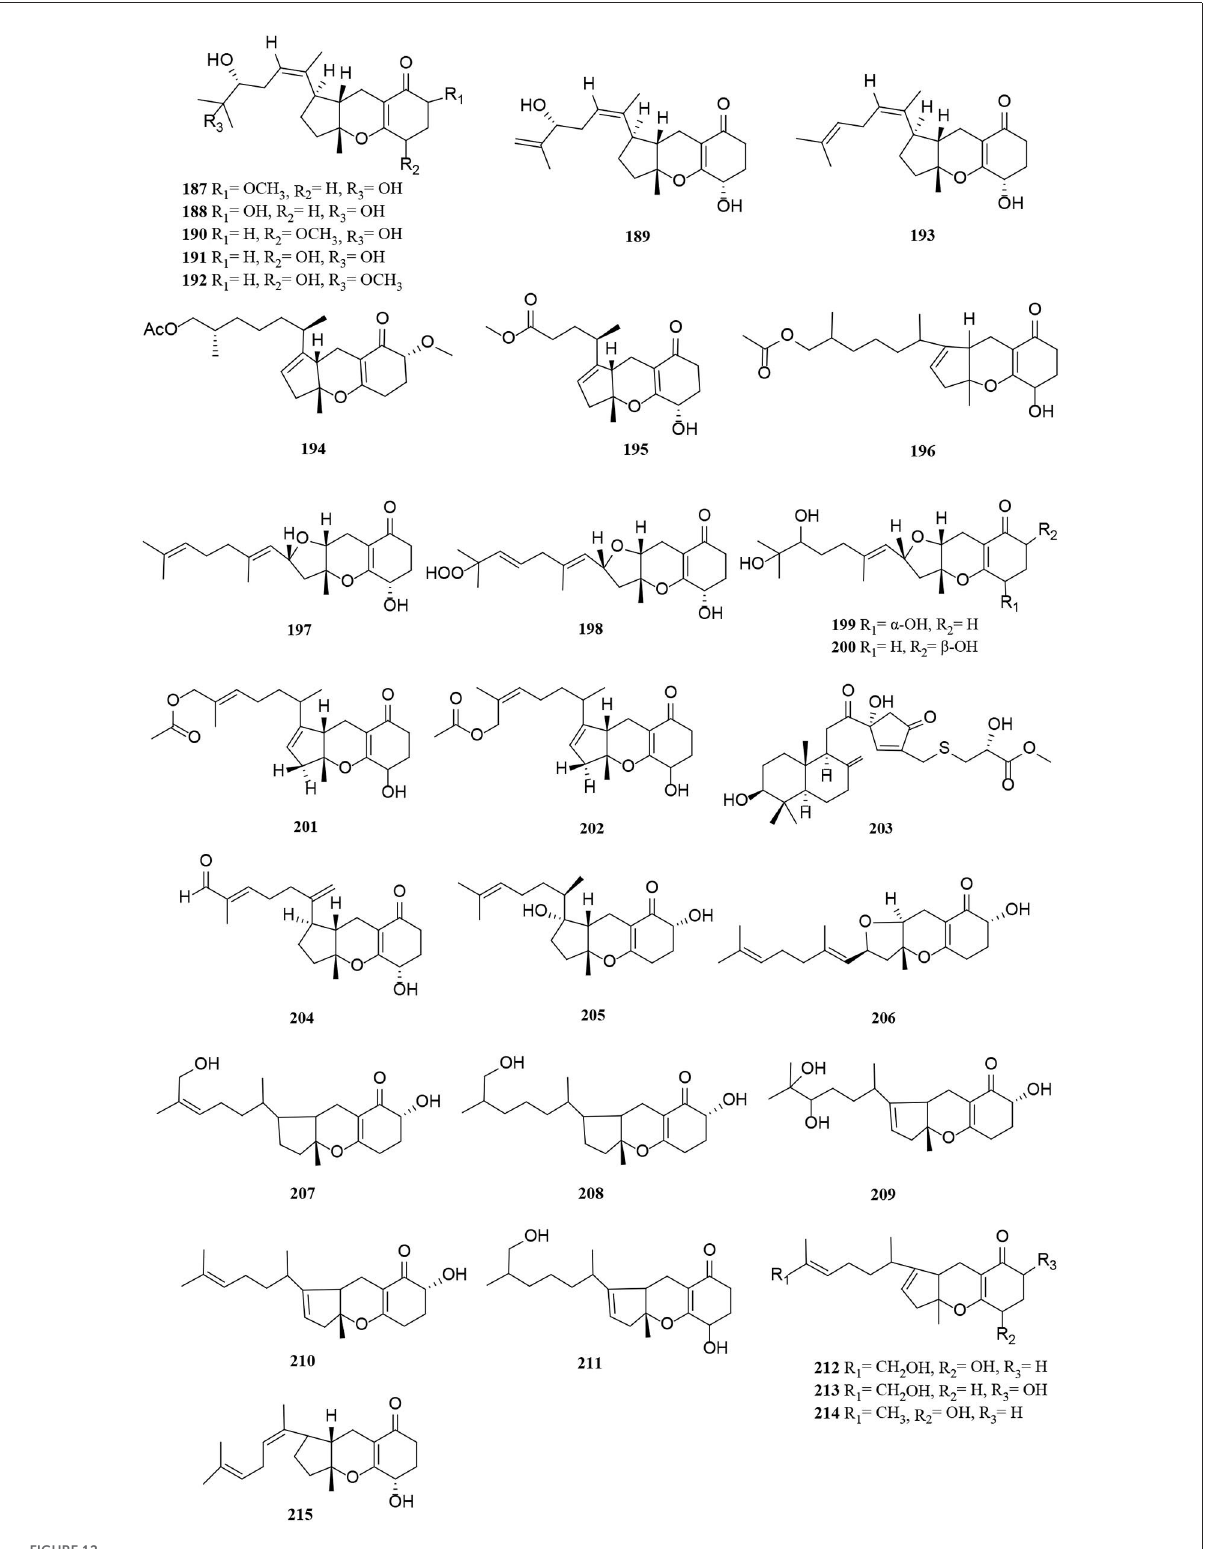
FIGURE12 Meroterpenoid derivatives ( 187 – 215 ) from Alternaria